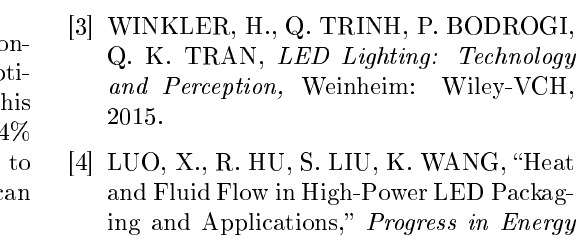
α -SrO · 3B 2 O 3 :Sm 2+ phosphor varies from 2% to 24%. The highest values of CRI and CQS are 80 and 70, respectively, which occur in the 24% α -SrO · 3B 2 O 3 :Sm 2+ case.